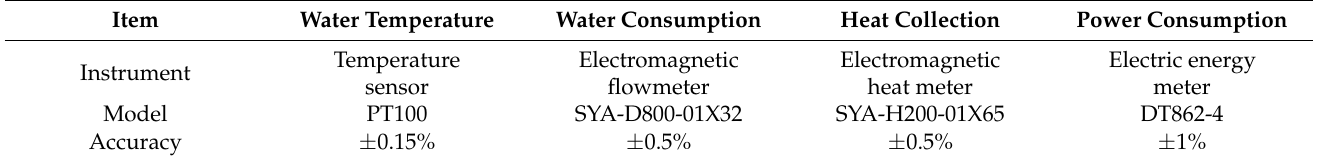
Table 1. The accuracy of the measuring instruments.